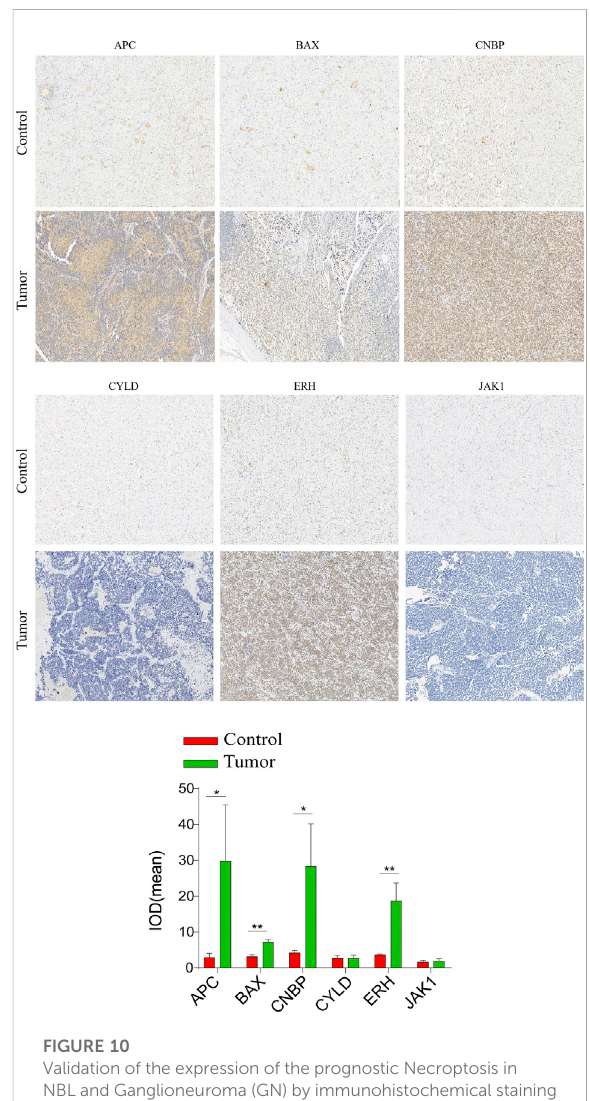
FIGURE 10 Validation of the expression of the prognostic Necroptosis in NBL and Ganglioneuroma (GN) by immunohistochemical staining analysis. The expressions of CYLD 、 JAK1 、 APC 、 ERH 、 CNBP, and BAX in NBL tissues and GN were detected by immunohistochemical staining (magni fi cation ×100). Quanti fi cation of immunohistochemical staining for CYLD 、 JAK1 、 APC 、 ERH 、 CNBP, and BAX by Image Pro Plus